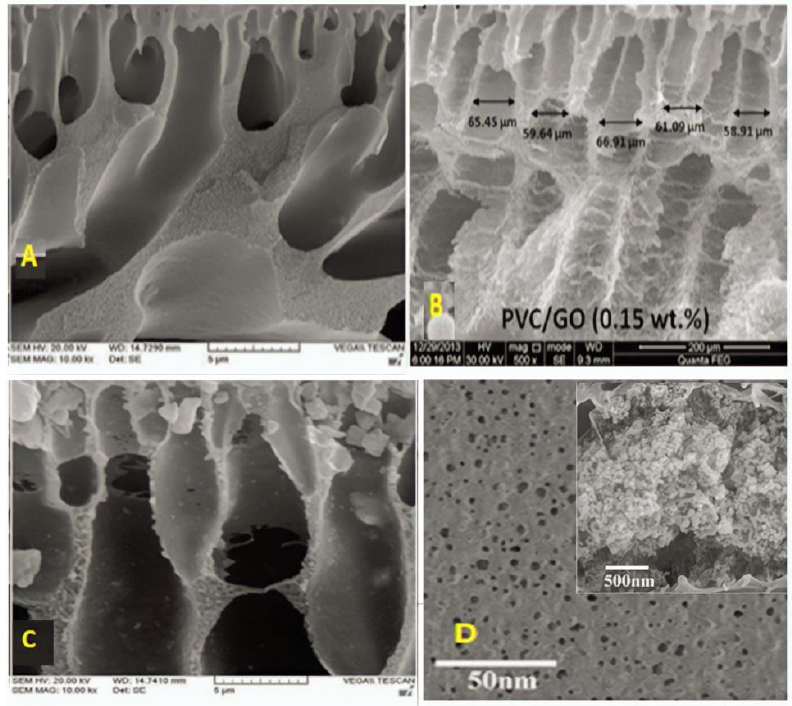
Figure 8. SEM images of the PVC membrane with different addition of nanoparticles. ( A ) Pure PVC [74], ( B ) 0.15 wt% GO [129], ( C ) 3 wt% ZnO [74], and ( D ) 2 wt%TiO 2 [117].